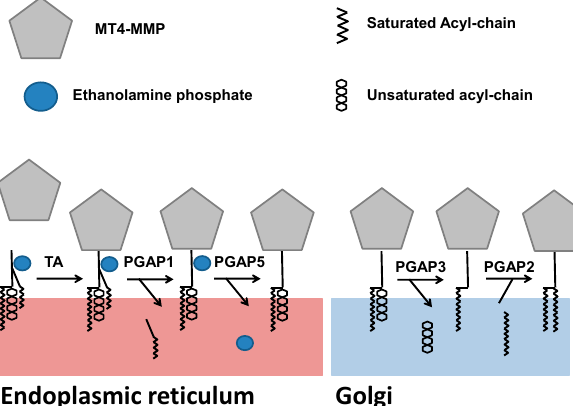
Figure 3. The biosynthesis of the glycosylphosphatidylinositol anchor on the MT4-MMP.